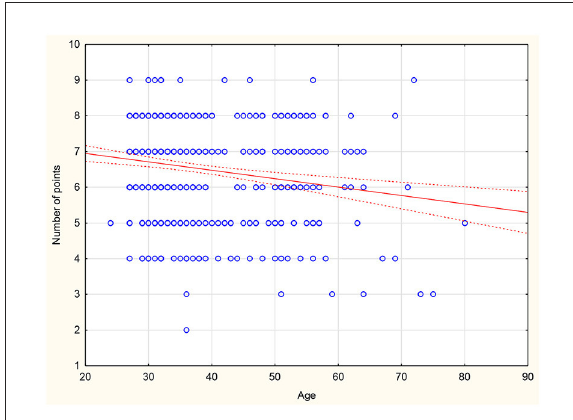
FIGURE3 Correlation between level of knowledge and scores on the CKD knowledge assessment